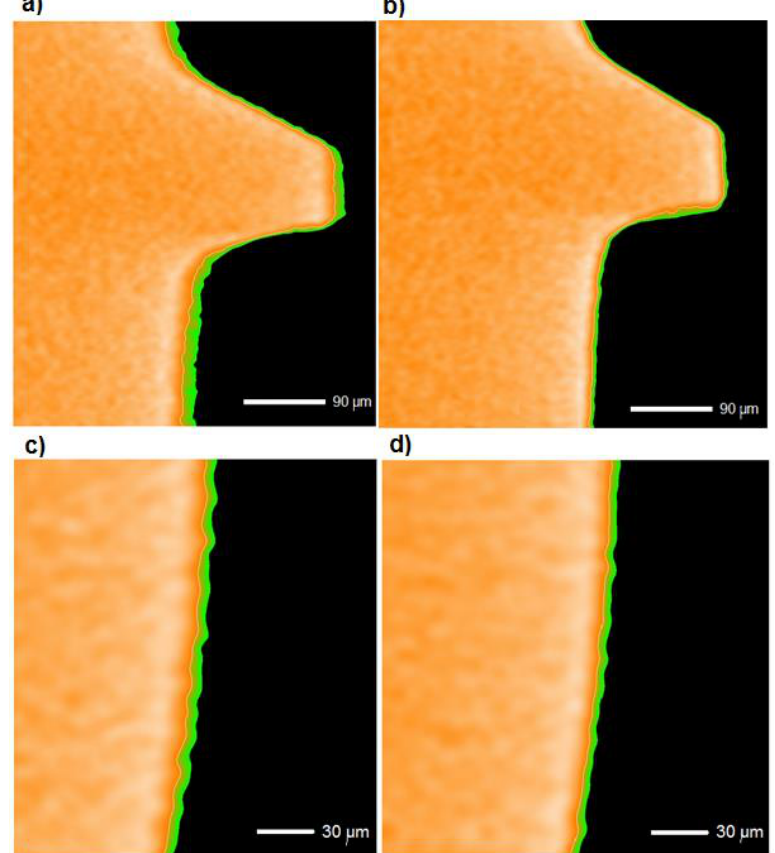
Figure 6. Images obtained by the computed tomography study of the sections: — longitudinal: ( a ) D company; ( b ) A company; — transverse dental implants: ( c ) D company; ( d ) A company.